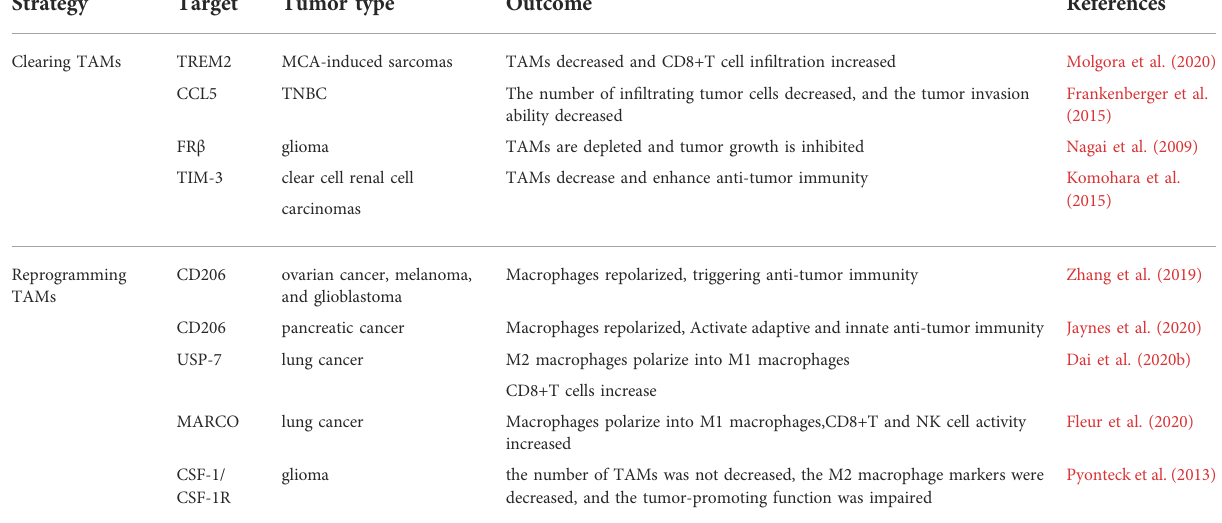
TABLE 2 Studies targeting TAMs in different